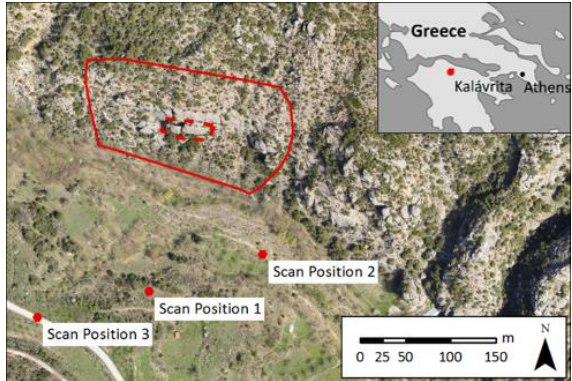
Figure 2. Location of the study site in Greece (38.06° N, 22.13° E) with the area of interest (red frame) and the extract used for the detailed study (red dashed frame).